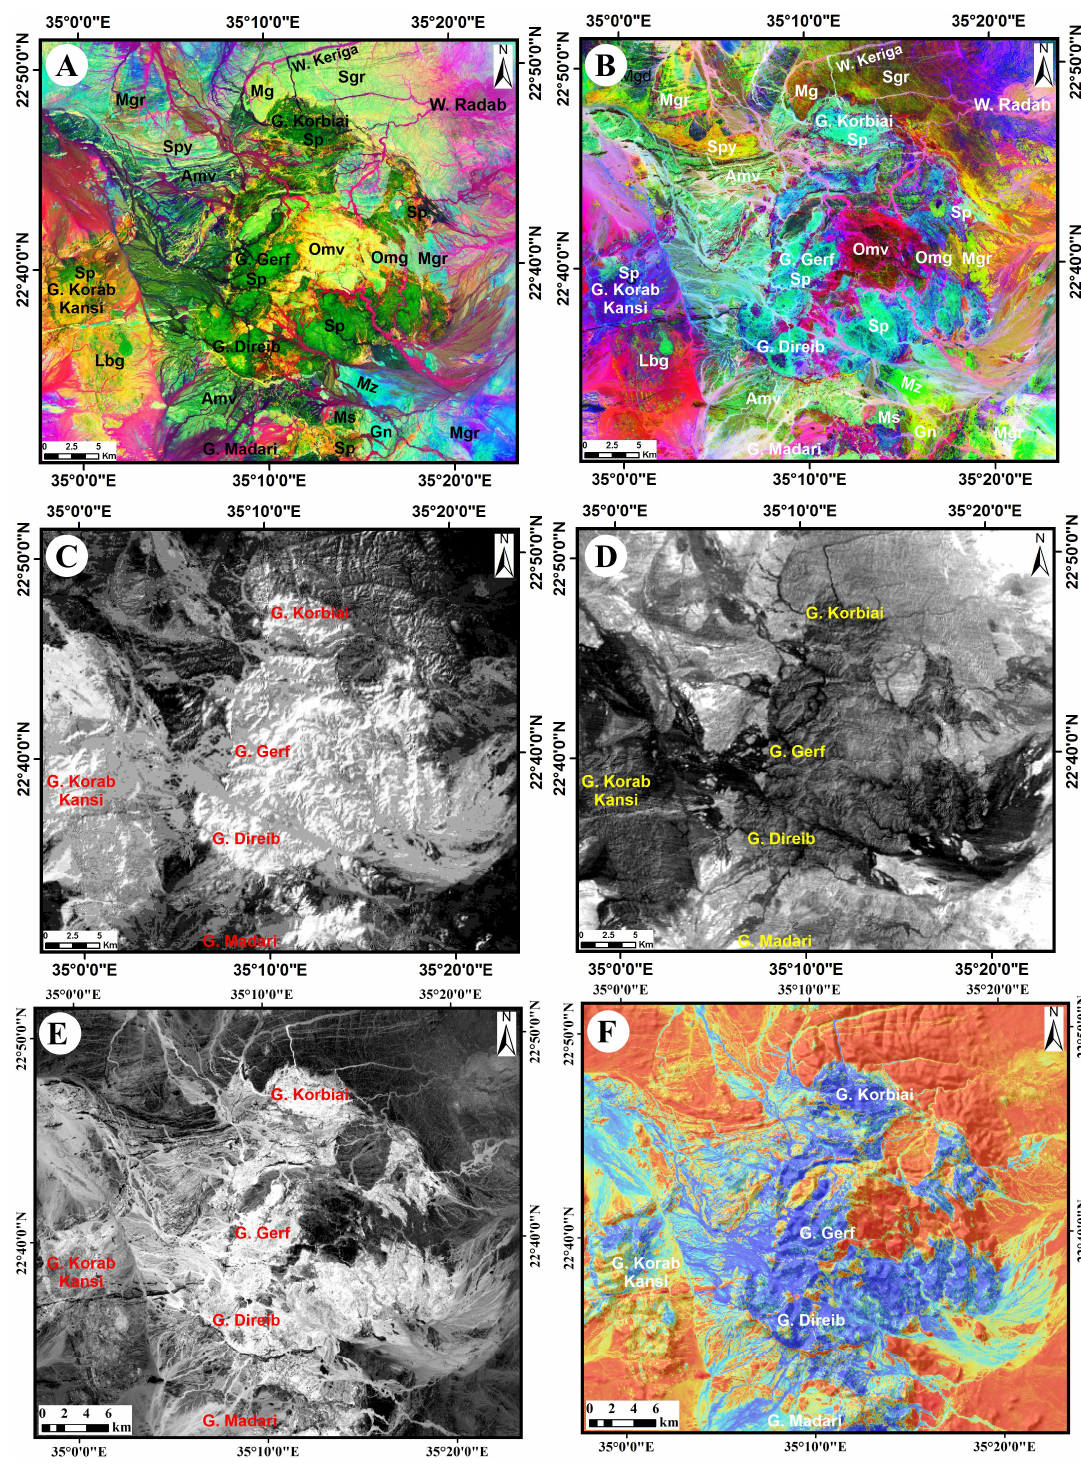
color and ophiolitic metavolcanics are represented by dark purple pixels where the ophi- olitic metagabbros have bluish cyan color. Whereas the highly deformed arc metavolcan- ics appear as light cyan to light green tones, foliated arc pyroclastics appear as greenish yellow, syn-granodiorite has dark brownish green to green pixels and layered gabbros moderate to dark grey pixels. A pseudo-color version of this image is shown in Figure 6F have a red color. The alteration zones of iron-oxide, hydroxyl minerals, and clay minerals where the serpentinite is distinguished by a dark blue color surrounded by shades of the can be easily detected by reddish-purple pixels around and over the serpentinite masses orange color of the other rock units. of G. Korab Kansi, G. Gerf and G. Korbiai.